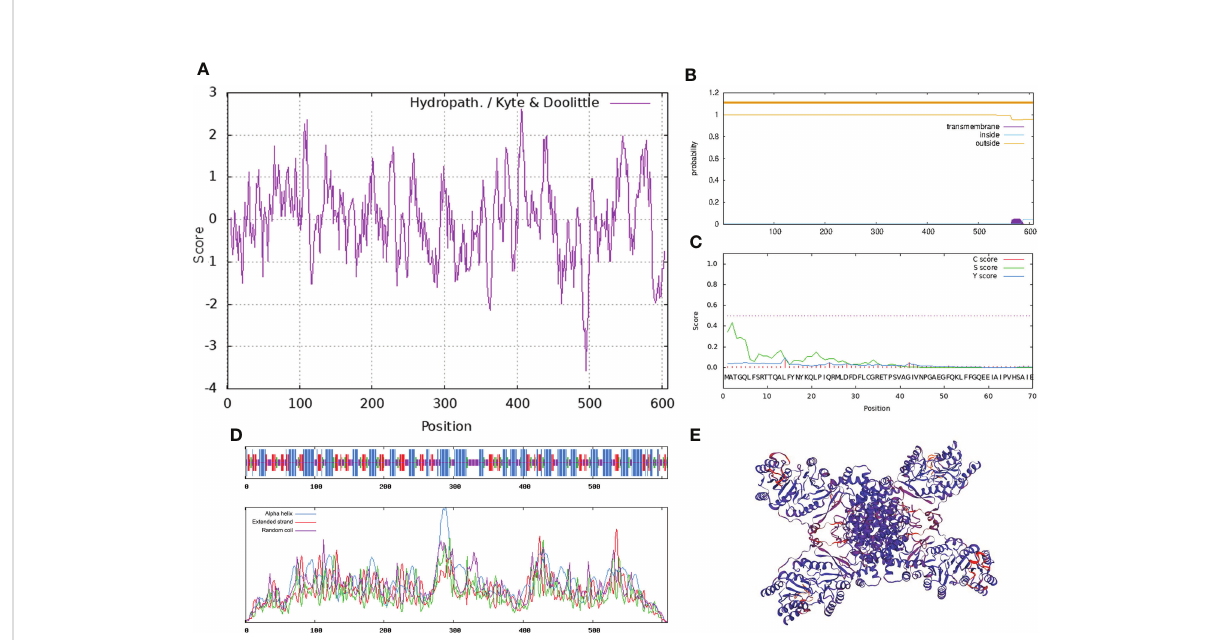
FIGURE 3 Bioinformatics analysi s of PlACLB2. (A) The hydrophobic property prediction of PlACLB2. (B) The transmembrane structure prediction of PlACLB2. (C) The signal peptide prediction of PlACLB2. (D) The secondary structure prediction of PlACLB2. (E) The tertiary structure prediction of PlACLB2.